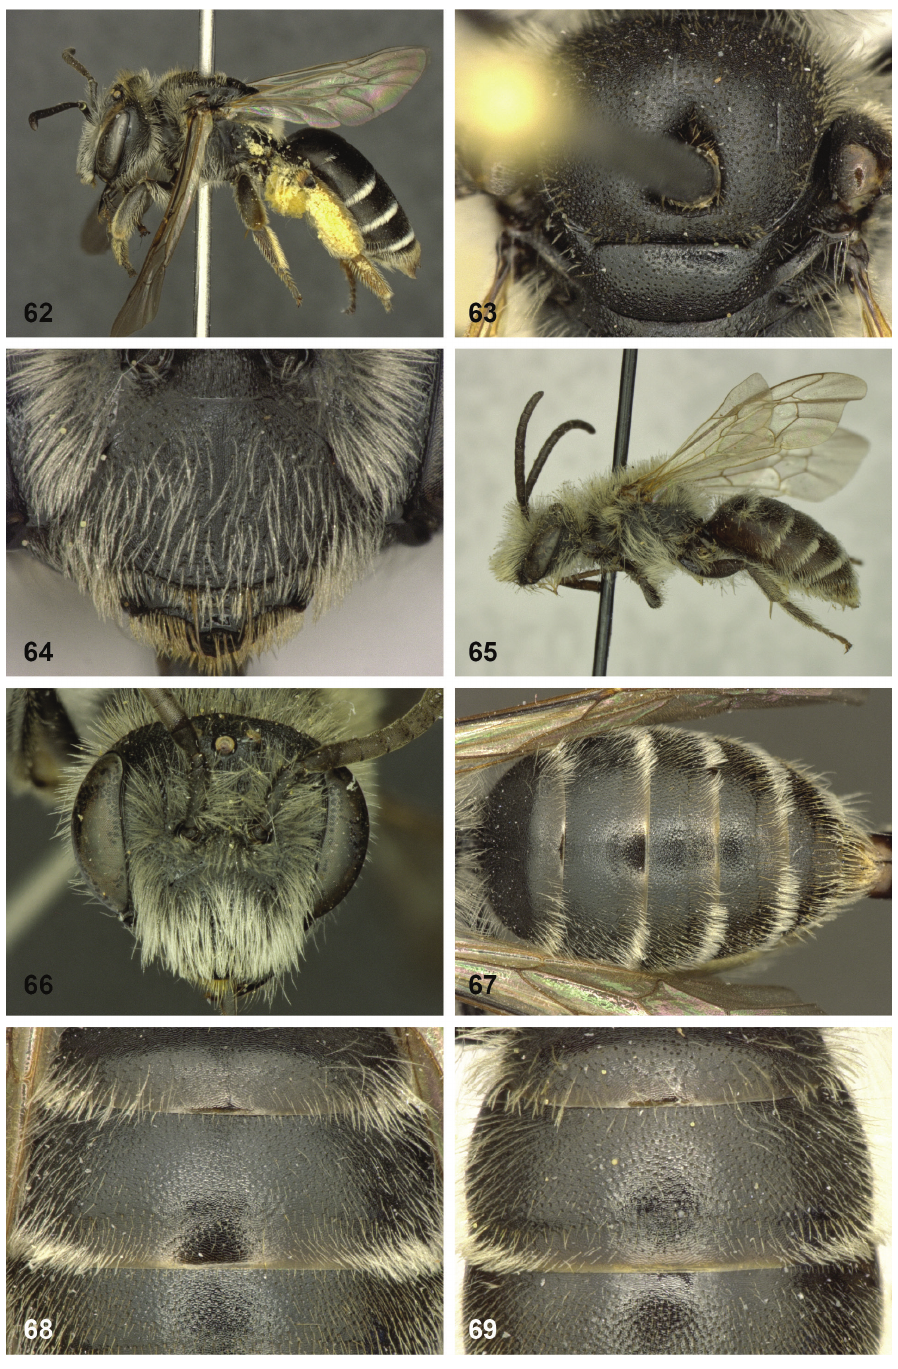
clypeus 65 male holotype of A. ovata , profile 66 male face 67 male metasoma 68 male metasomal terga 1–3 69 A. wilkella , male metasomal terga